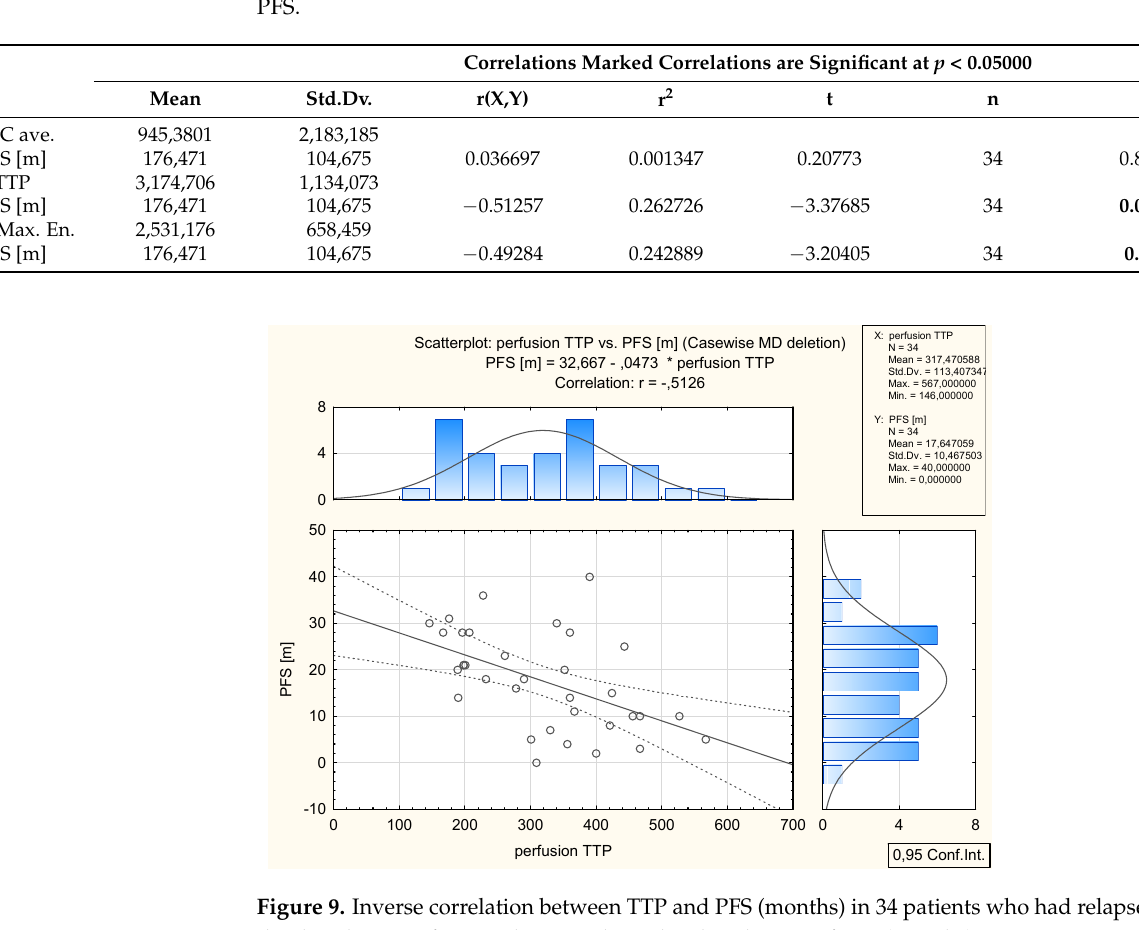
Figure 9. Inverse correlation between TTP and PFS (months) in 34 patients who had relapsed. Above: the distribution of TTP values; on the right: distribution of PFS (months).